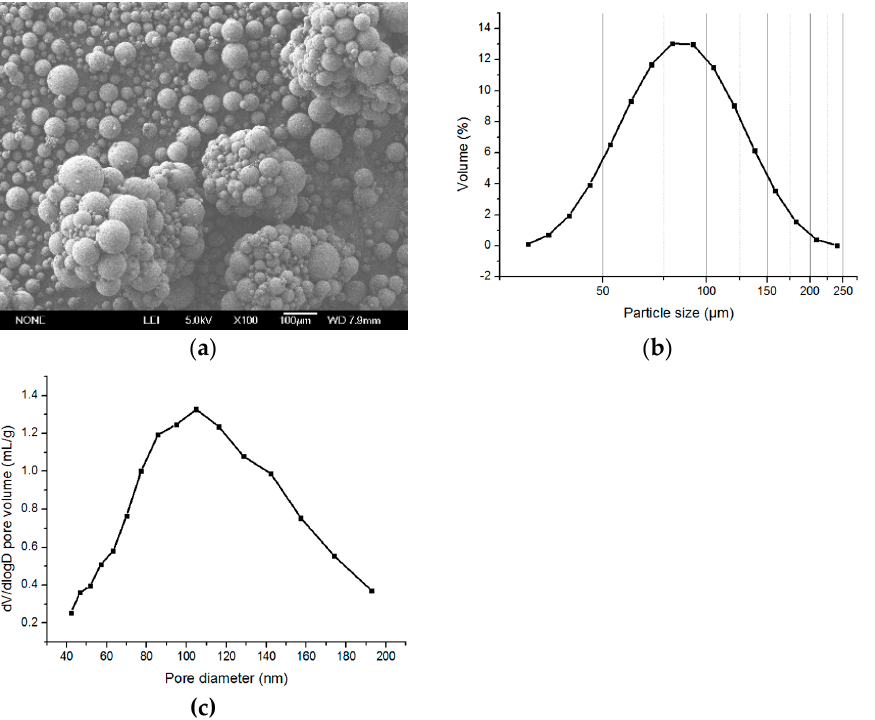
Figure 5. ( a ) The SEM image (×100), ( b ) size distribution (dispersed), and ( c ) pore distribution of control group.